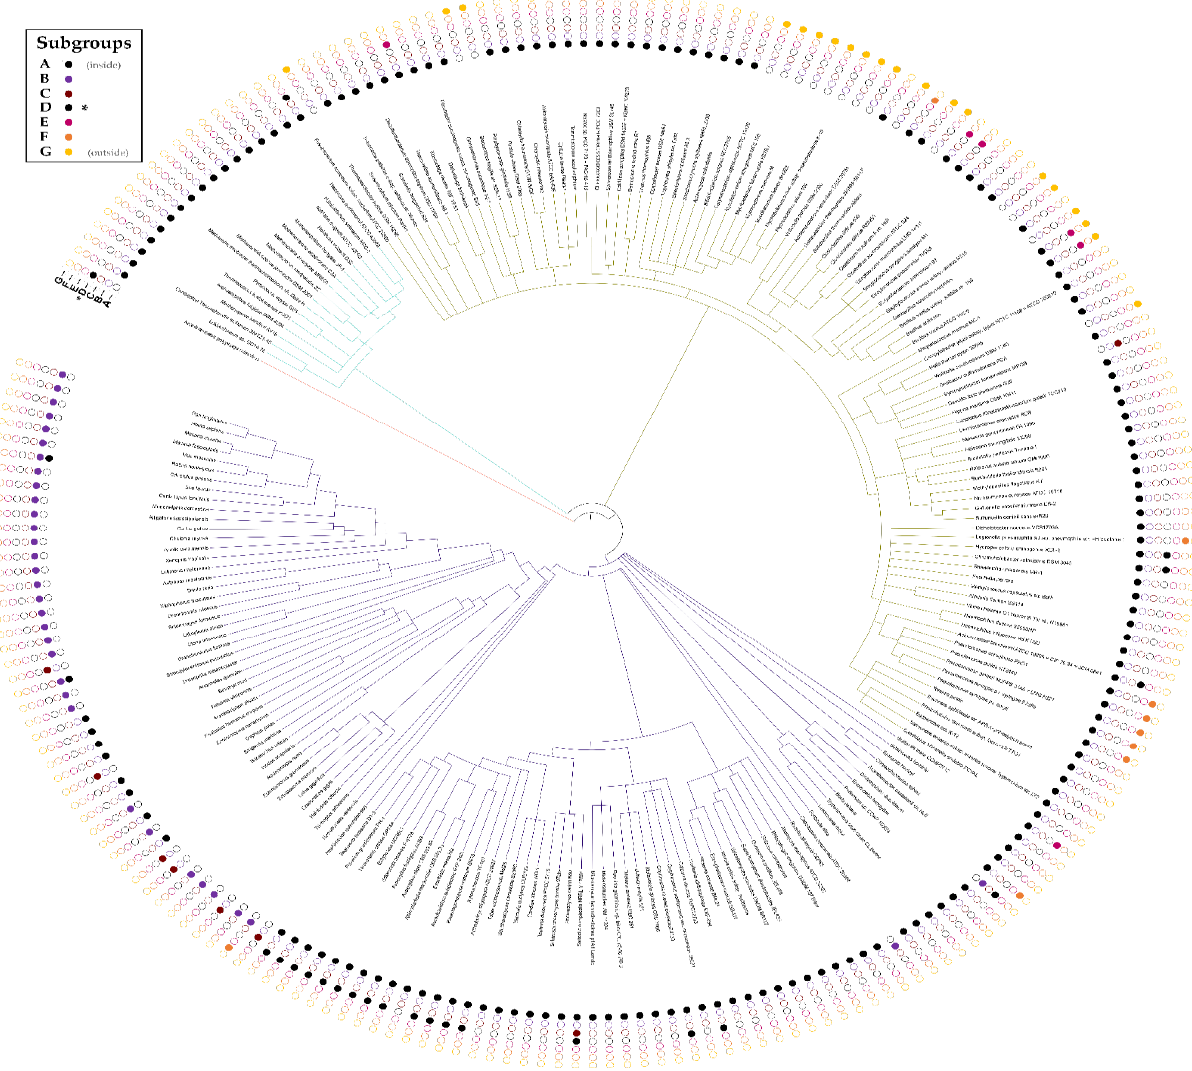
Figure 5. Absence–presence of DUF34 architectural domain subgroups. Absence–presence data of COGs and HMM-determined InterPro family/superfamily/domain signature profiles added to a species tree, generated using organisms harboring published homologs and those used in alignments acquired via OrthoInspector (Data Table S4). Proteins are designated as categories A-G, as detailed in Figure 4 and Data Table S5. These homologous domains are classified in the map according to their HMM-defined DUF34 domain identities (see Figure 4a).